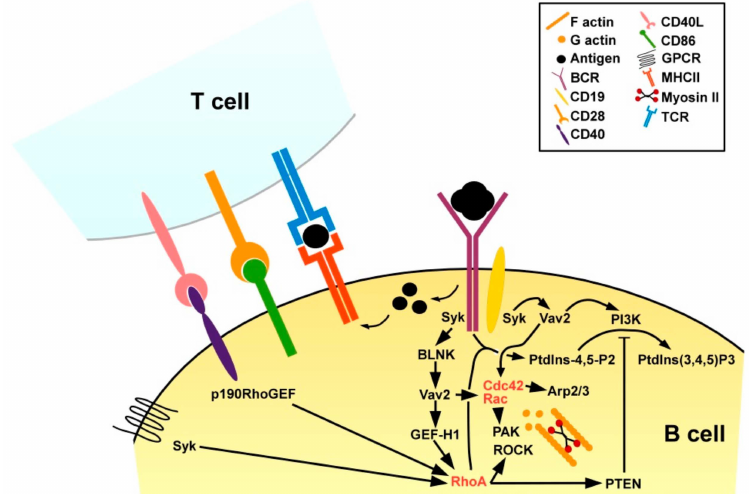
Figure 9. BCR activation and concomitant T cell help activate RhoA and other small GTPases in B cells. Binding of a protein antigen by an antigen-specific BCR supported by the co-receptor CD19 triggers Syk which, in turn, activates Vav2 mediating, e.g., via the GEF GEF-H1 activation of RhoA, and of other small GTPases, as well as PI3K activation. RhoA via PTEN negatively regulates PI3K. Antigen-specific CD4 + T cells that bind antigen presenting B cells and receive co-stimulation via CD86 / CD28 transiently upregulate CD40L. Binding of CD40 by CD40L activates RhoA via p190RhoGEF. In addition, chemokines may stimulate